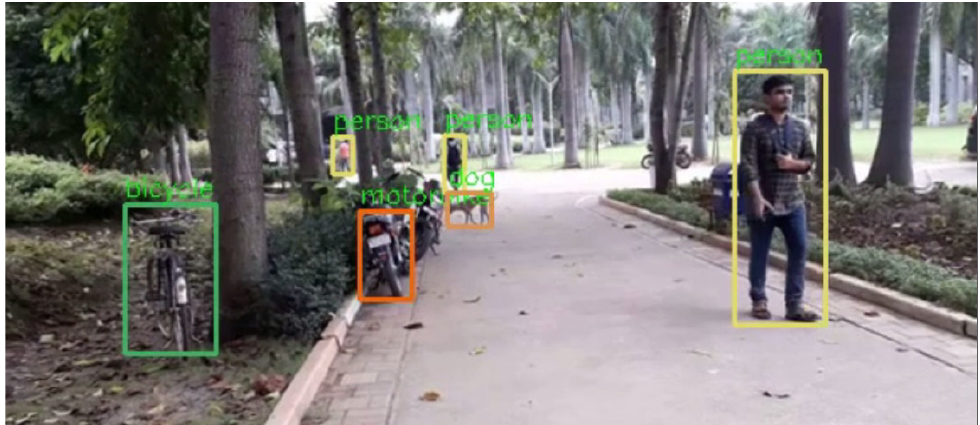
Figure 16. Object detection and recognition from a video sequence (Example 1).